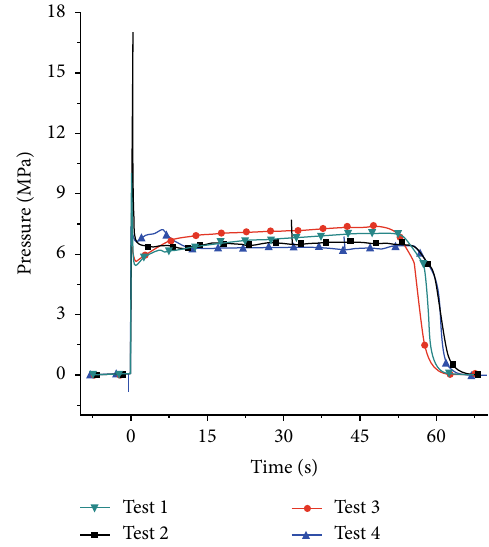
Figure 5: Pressure-time curve of test.